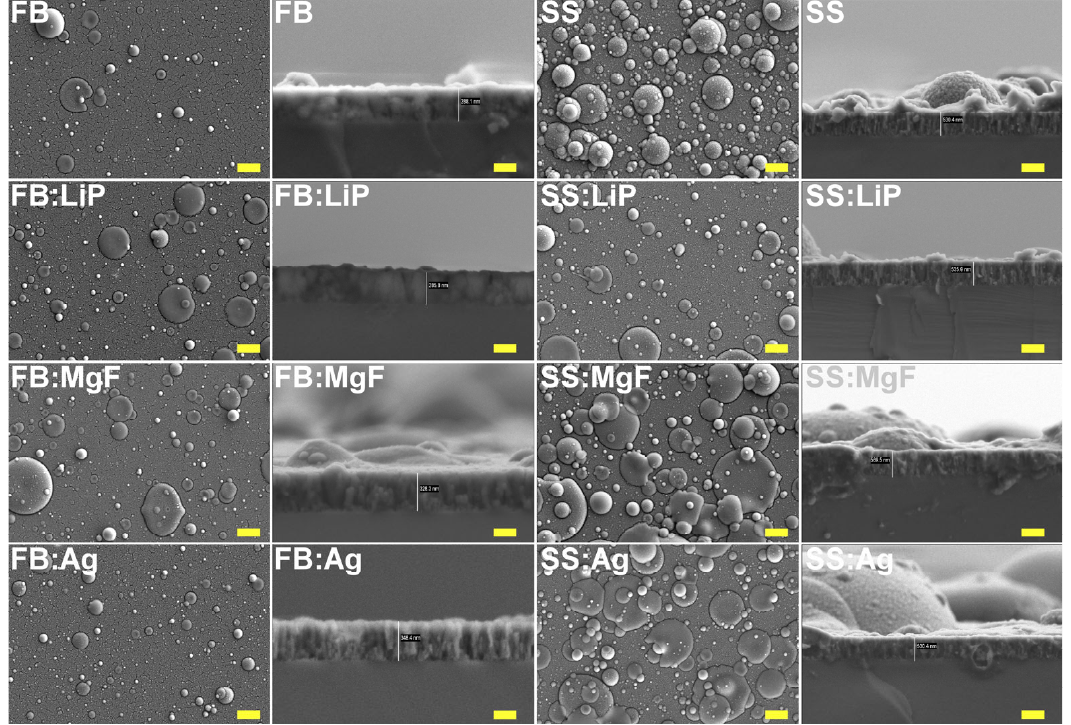
Figure 1. Top-view and cross-sectional SEM micrographs of simple and doped fish bone (FB) and seashell